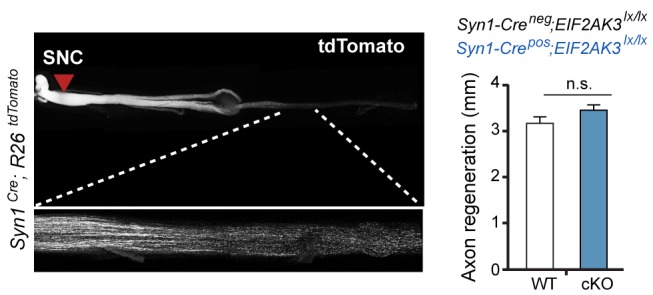
Assessment of PERK influence on axon regeneration in vivo after SNC.(left) Identification of tdTomato-positive (Syn1-Cre;R26LSL.tdTomato) axon regeneration front by whole-mount sciatic nerve epifluorescence (top), confirmed by two-photon optical sectioning of a sciatic nerve (bottom) seven days after SNC (red arrow indicates injury site). (right) tdTomato-positive axon regeneration front is not significantly improved in Syn1-Cre;R26LSL.tdTomato;Eif2ak3lx/lx (PERK cKO) mice (n ≥ 5 per condition, p=0.12).